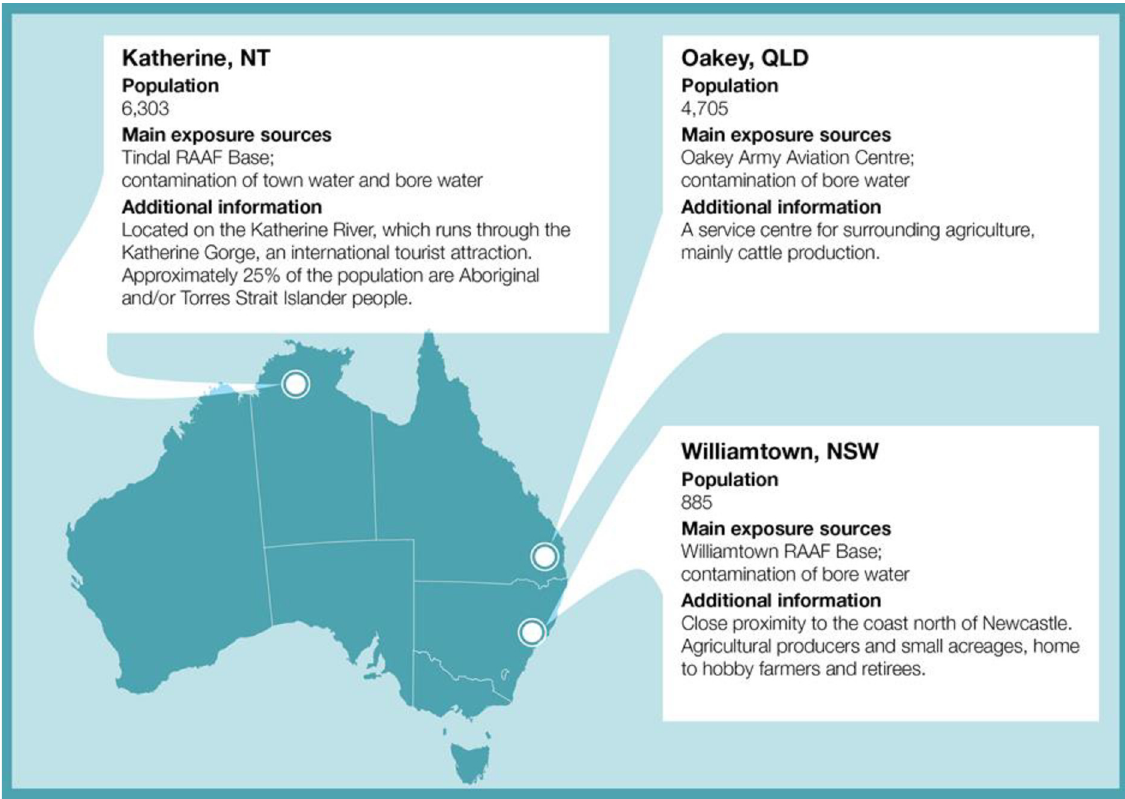
Fig 1. Characteristics of the PFAS affected communities of Williamtown, Oakey and Katherine. Population data sourced from QuickStats, Australian Census, 2016 (Australian Bureau of Statistics 2016).